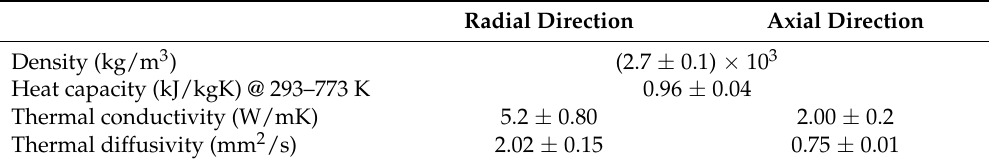
Table 2. Thermophysical properties along the parallel (radial) and perpendicular (axial) direction to the layers forming a slate tile (Valdeorras variety)